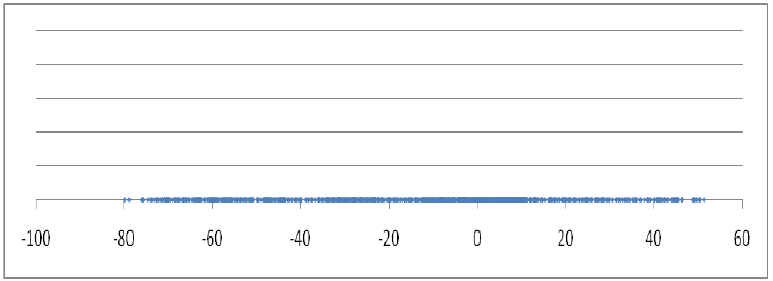
Figure 15. Random route with 1,000 points in 1-dimensional space.